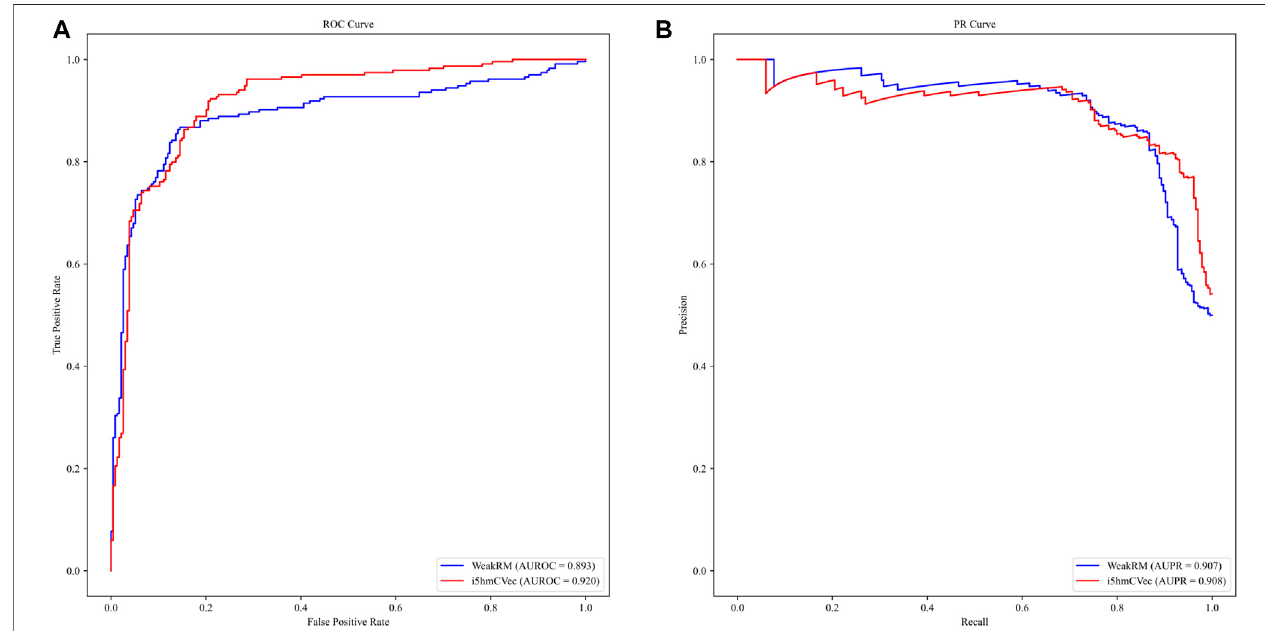
FIGURE6| ROCandPRcurvesofi5hmcVecandWeakRMonthedatasetfromWeakRM. (A) ROCcurve.TheX-axisisthefalsepositiverate,andtheY-axisisthe true positive rate. (B) PR curve. The X-axis is the recall, and the Y-axis is the precision.